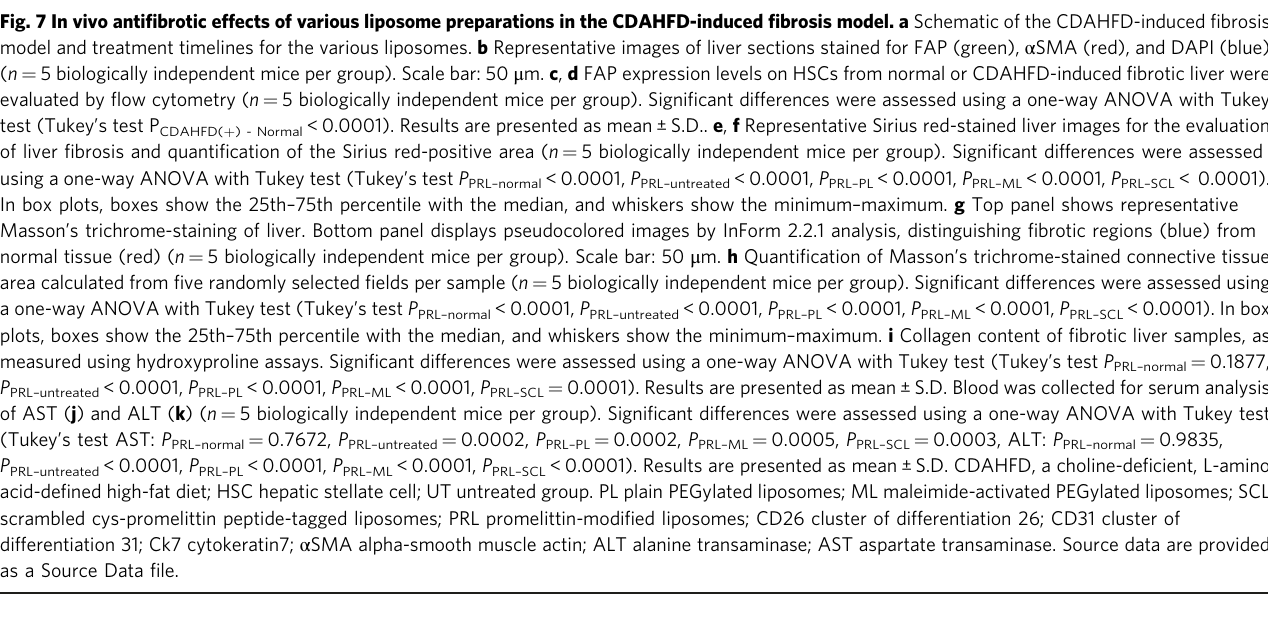
Fig. 7 In vivo anti fi brotic effects of various liposome preparations in the CDAHFD-induced fi brosis model. a Schematic of the CDAHFD-induced fi brosis model and treatment timelines for the various liposomes. b Representative images of liver sections stained for FAP (green), α SMA (red), and DAPI (blue) ( n = 5 biologically independent mice per group). Scale bar: 50 μ m. c , d FAP expression levels on HSCs from normal or CDAHFD-induced fi brotic liver were evaluated by fl ow cytometry ( n = 5 biologically independent mice per group). Signi fi cant differences were assessed using a one-way ANOVA with Tukey test (Tukey ’ s test P CDAHFD( + ) - Normal < 0.0001). Results are presented as mean ± S.D.. e , f Representative Sirius red-stained liver images for the evaluation of liver fi brosis and quanti fi cation of the Sirius red-positive area ( n = 5 biologically independent mice per group). Signi fi cant differences were assessed using a one-way ANOVA with Tukey test (Tukey ’ s test P PRL – normal < 0.0001, P PRL – untreated < 0.0001, P PRL – PL < 0.0001, P PRL – ML < 0.0001, P PRL – SCL < 0.0001). In box plots, boxes show the 25th – 75th percentile with the median, and whiskers show the minimum – maximum. g Top panel shows representative Masson ’ s trichrome-staining of liver. Bottom panel displays pseudocolored images by InForm 2.2.1 analysis, distinguishing fi brotic regions (blue) from normal tissue (red) ( n = 5 biologically independent mice per group). Scale bar: 50 μ m. h Quanti fi cation of Masson ’ s trichrome-stained connective tissue area calculated from fi ve randomly selected fi elds per sample ( n = 5 biologically independent mice per group). Signi fi cant differences were assessed using plots, boxes show the 25th – 75th percentile with the median, and whiskers show the minimum – maximum. i Collagen content of fi brotic liver samples, as measured using hydroxyproline assays. Signi fi cant differences were assessed using a one-way ANOVA with Tukey test (Tukey ’ s test P PRL – normal = 0.1877,